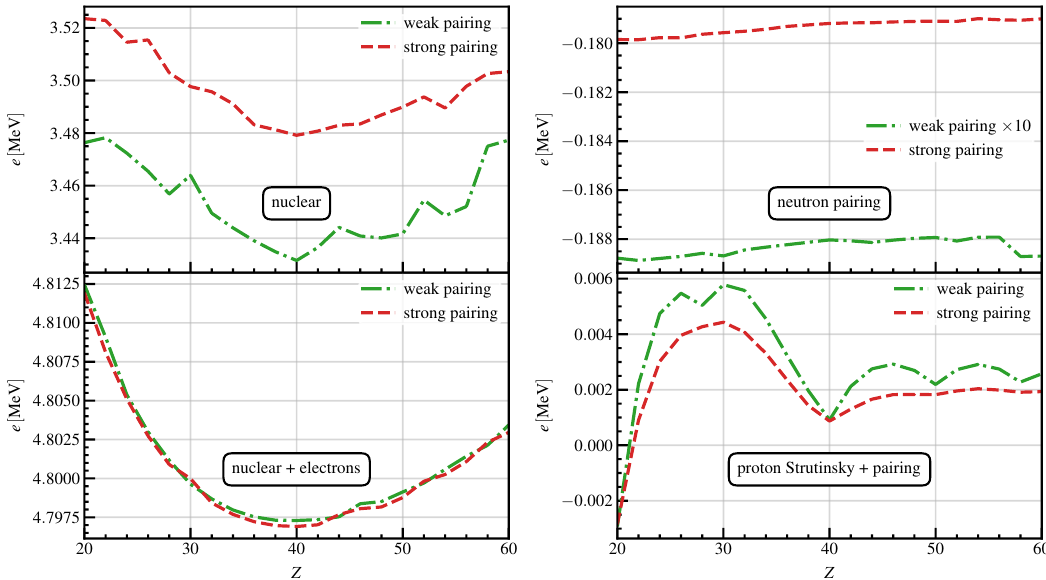
Figure 4. Individual contributions to energy per particle, e , for a Wigner Seitz cell with ρ b = 0.02 fm − 3 . Results are shown for the two pairing strengths used with the SLy4 functional (green dash-dotted line shows weak, red dashed line shows strong). The top left panel shows only e Sky , while the bottom left shows e Sky + e e ; see Equation (2) and text for details. In the top-right panel for neutron pairing, showing e cond (Equation (8)), the weak result has been multiplied by 10 to make clear the variations for weak and strong on the same